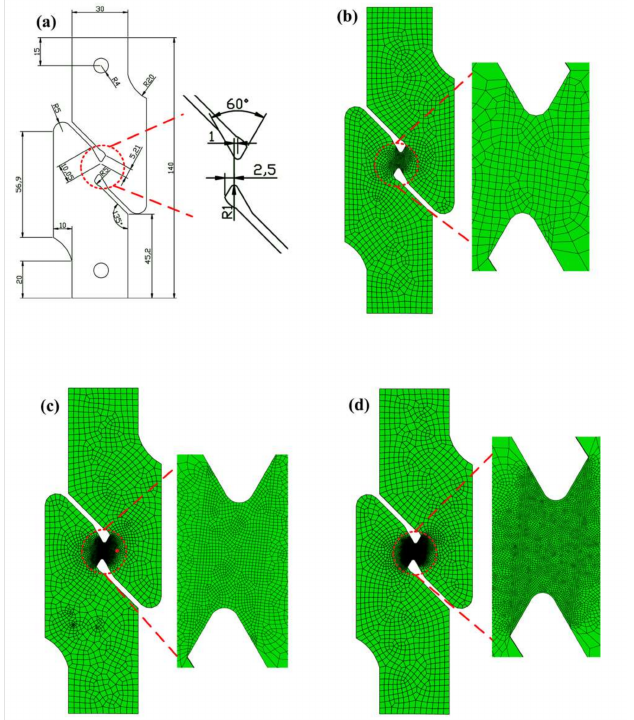
Figure 6. Sample geometry and three models with different number of meshes: ( a ) Sample geometry; ( b ) Model with 6852 elements, 3 layers; ( c ) Model with 14,720 elements, 4 layers; ( d ) Model with 37,420 elements, 5 layers.